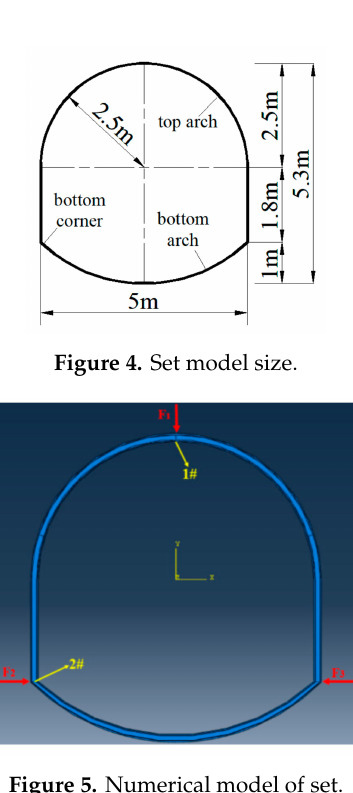
Figure 5. Numerical model of set.